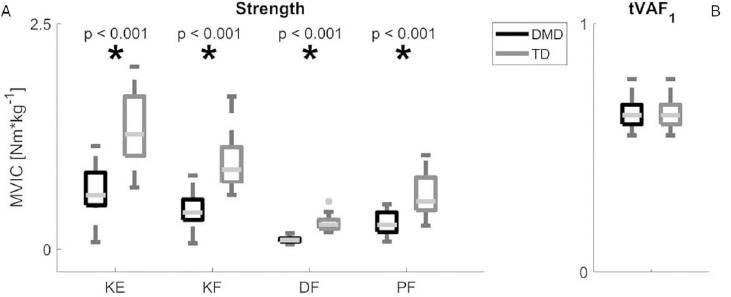
Fig 1. Results of MWU tests for MVICs and tVAF 1 ( α = 0.01). (A-B) show the median + interquartile ranges of the MVICs (A) of the KE, KF, DF and PF and tVAF 1 (B). Significant differences between TD (grey) and DMD (black) based on the outcomes of MWU are indicated with an asterisk. Abbreviations in alphabetic order: DF = dorsiflexion; DMD = Duchenne muscular dystrophy; KE = knee extension; KF = knee flexion; MVIC = maximal voluntary isometric contraction; MWU = Mann-Whitney U; Nm � kg -1 = Newton meters per kilogram body weight; PF = plantar flexion; TD = typically developing; tVAF 1 = total variance accounted for by one synergy.